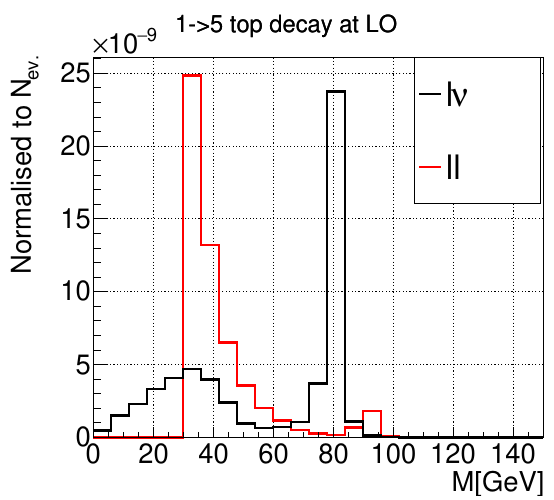
Figure 4 . The normalised invariant mass distributions of the ‘ν and ‘‘ pairs in the 5-body, t → be + e − µ + ν µ decay, where different lepton flavours were simulated to distinguish those predominantly coming from intermediate neutral and charged gauge bosons. The top decay is performed in the 5FS and using the complex mass scheme at LO. A minimum invariant-mass cut of 30 GeV is imposed on the same-flavour, opposite-charge lepton pair. The neutral final state invariant mass is dominantly away from the Z